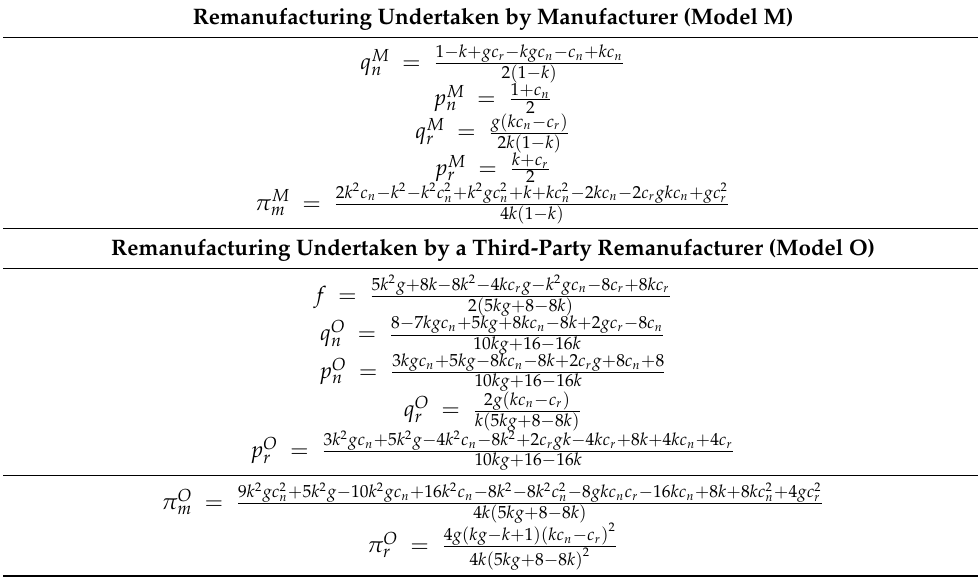
Table 3. Equilibrium decisions and